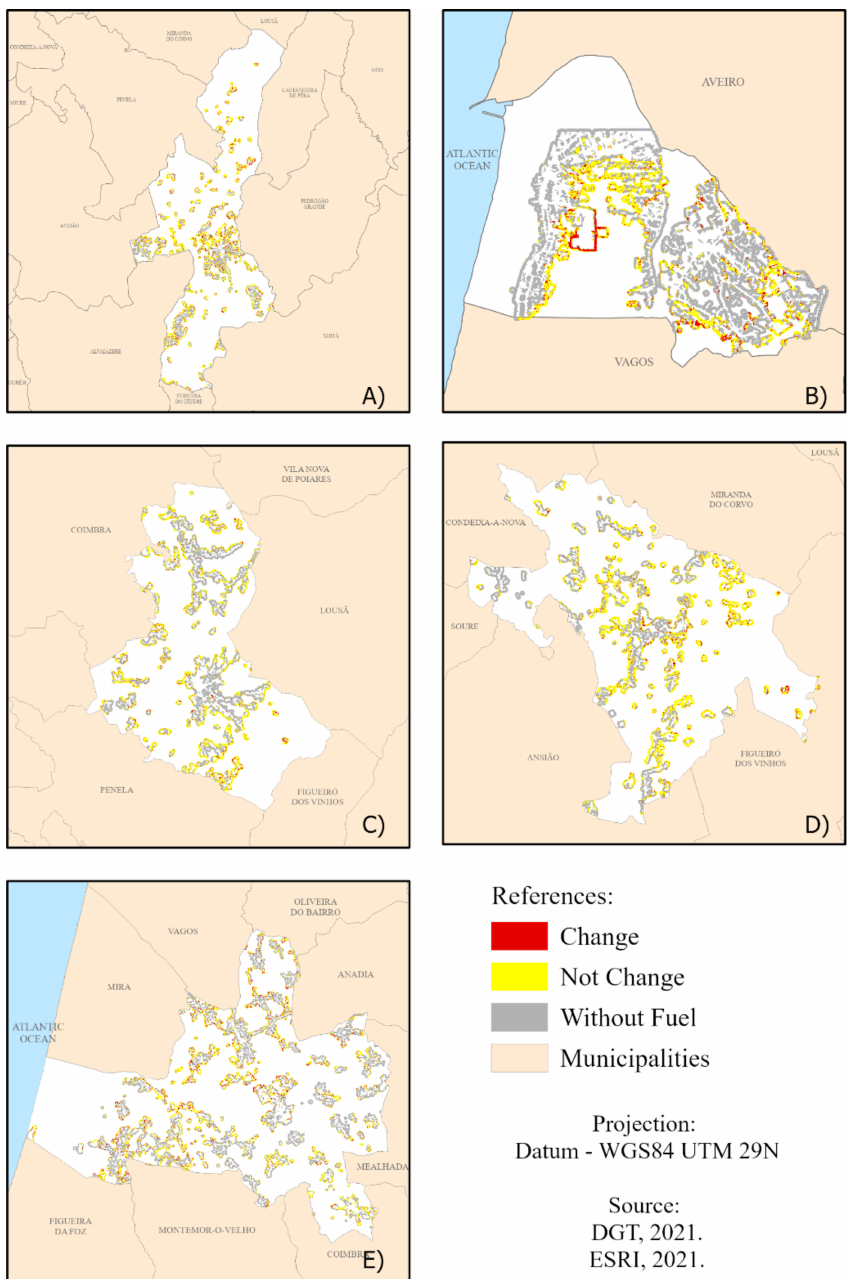
Figure 3. Changes detected in: ( A ) Figueir ó dos Vinhos, ( B ) Í lhavo, ( C ) Miranda do Corvo, ( D ) Penela, ( E ) Cantanhede, with p -value ≤